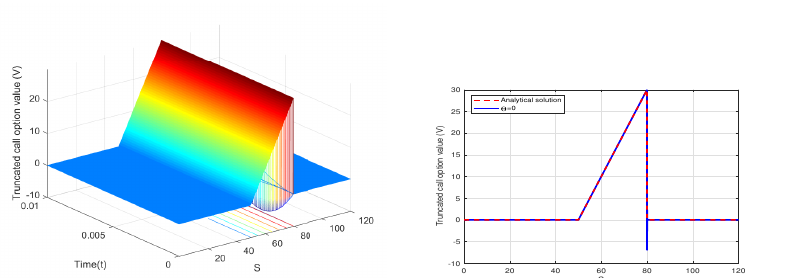
Figure 1. Spurious oscillations in the solution provided by the θ -method with ∆ S = 0.01, ∆ t = 10 − 4 , and θ = 0. Parameter values: r = 0.07, σ = 0.001, T = 0.01, U = 80, K = 50, L = 20, S max = 120.